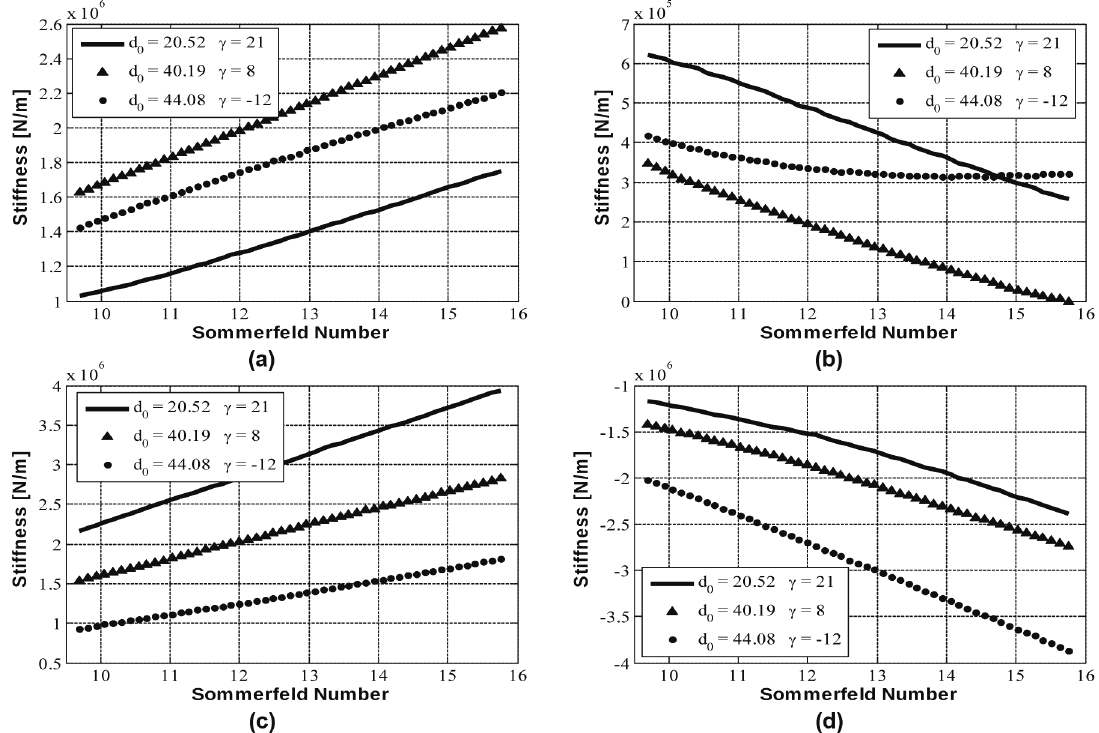
, (b) K , (c) K and (d) K yy zz yz